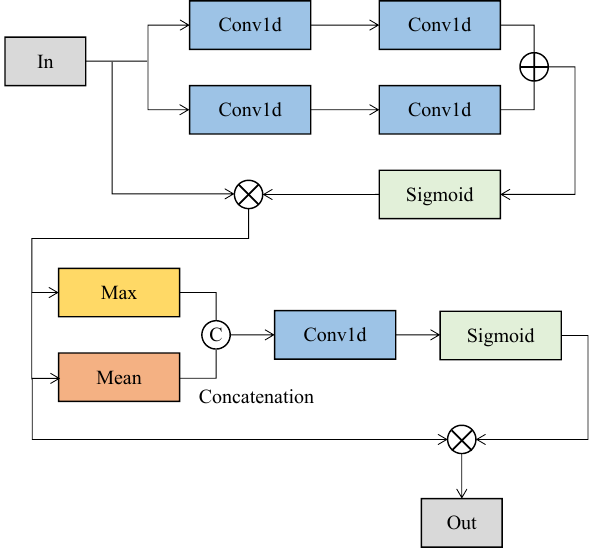
Figure 3. The AttenA